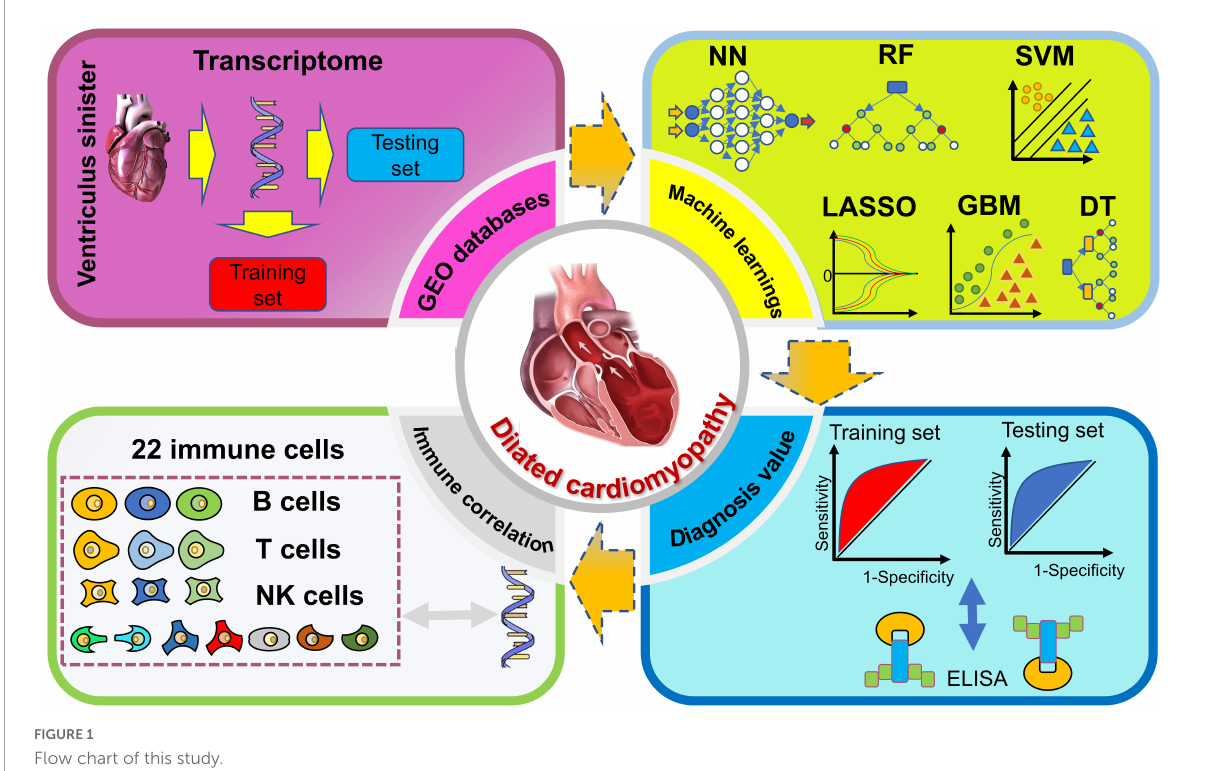
FIGURE1 Flow chart of this